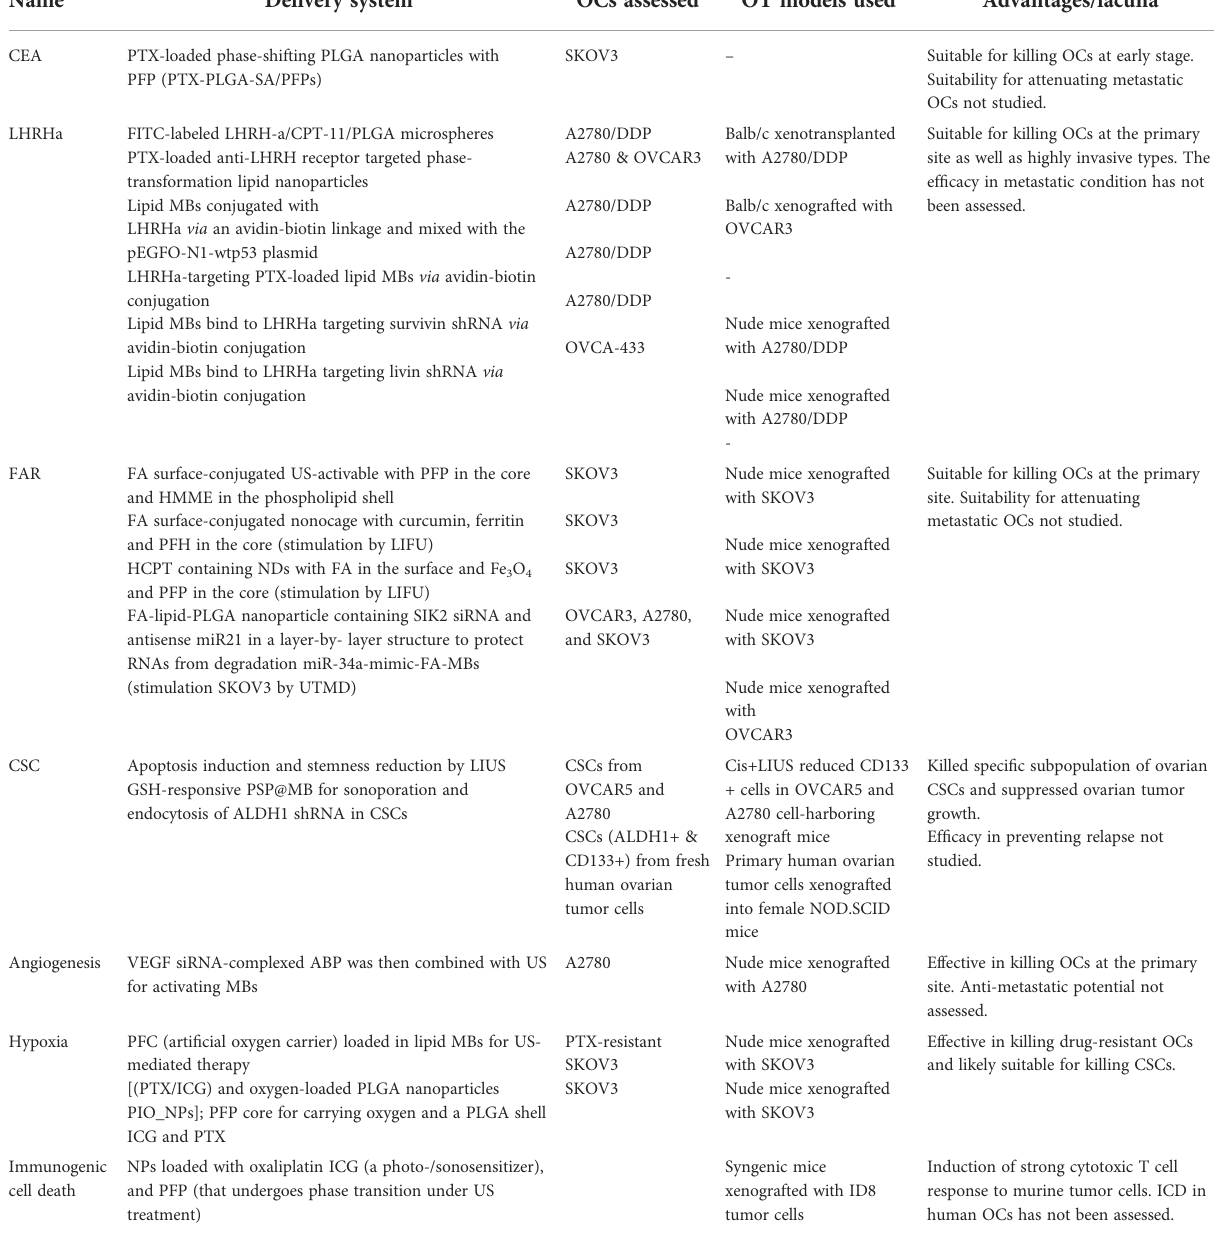
TABLE 3 Strategies for targeted delivery of small molecule drugs/biologics to ovarian cancers by US